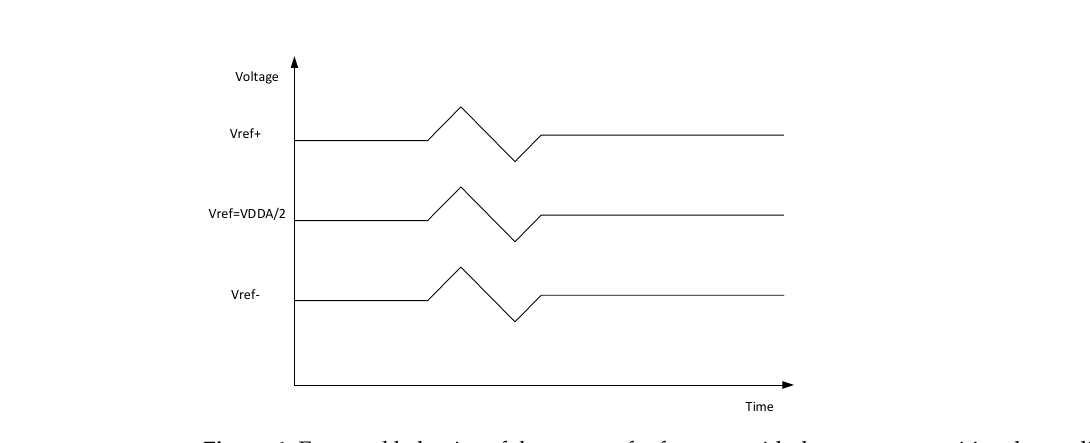
Figure 5. Proposed simplified low-power scheme, with low (Vref − ) and high (Vref+) references wire connections.